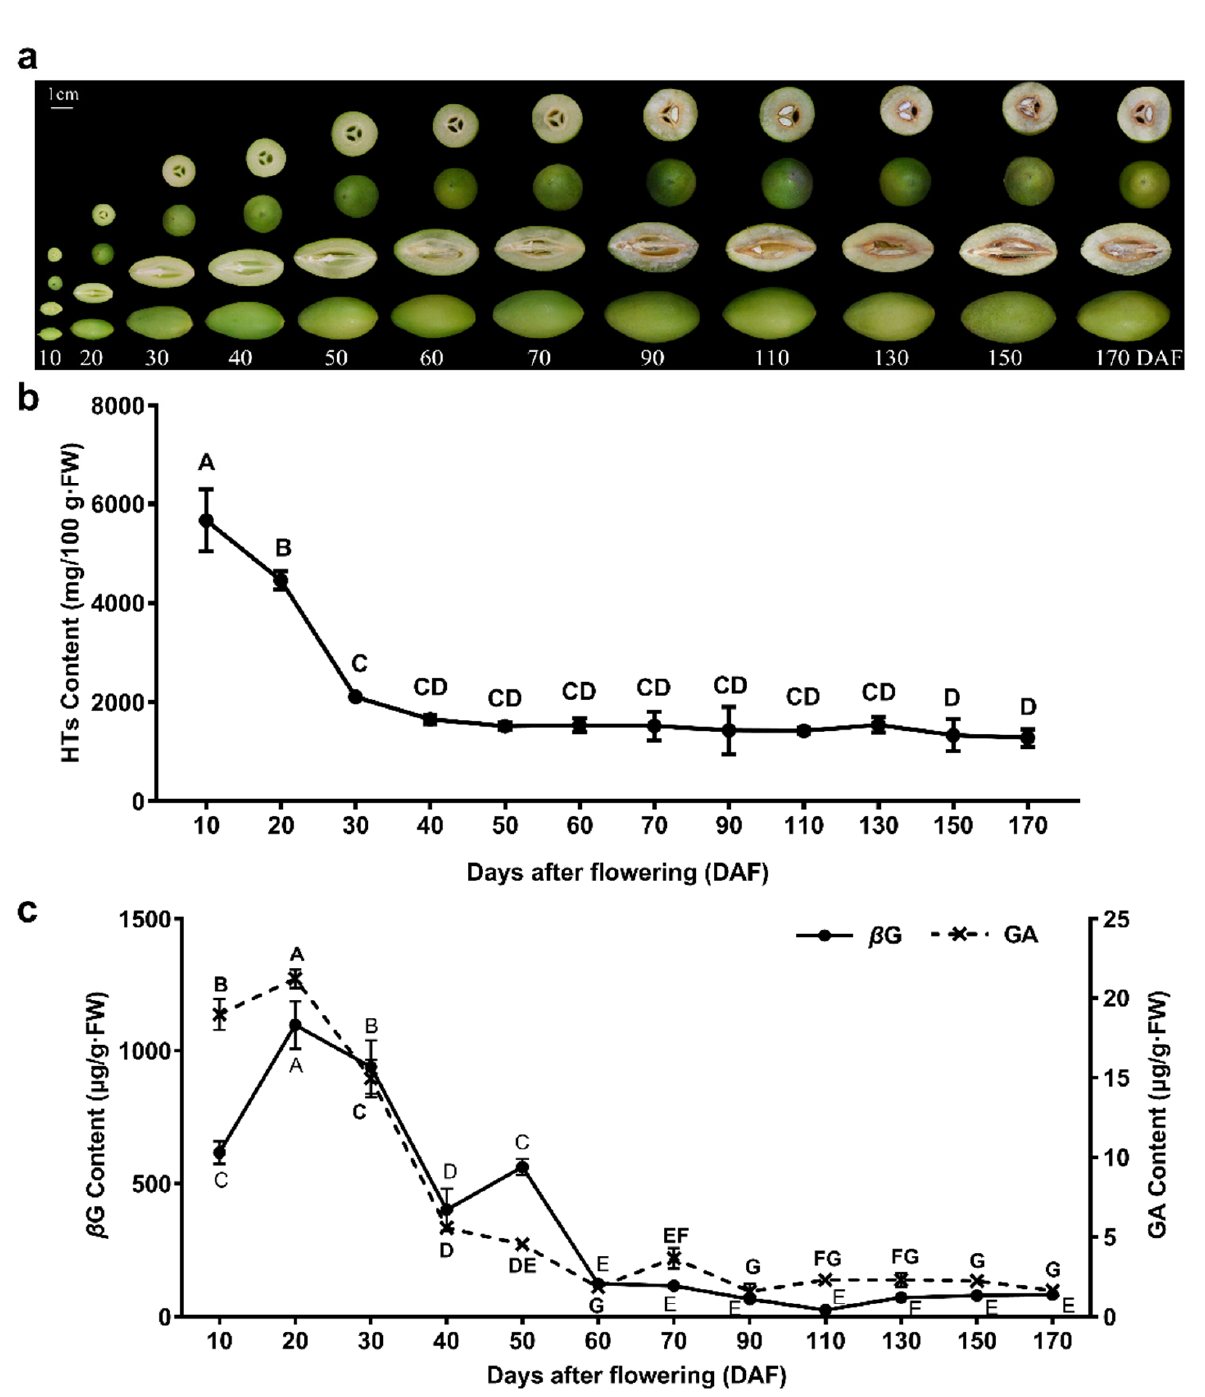
Figure 1. C. album fruit development and phenolic substance content. ( a ) The exterior and interior characteristics of C. album fruits in different development stages; ( b ) hydrolysable tannin (HT) content of C. album fruits in different development stages; ( c ) gallic acid (GA) and 1-Galloyl- β - D -glucose ( β G) contents of C. album fruits in different development stages. Each data point is the average mean of five reactions ± SD. Different uppercase letters indicate significant differences at p < 0.01 levels, based on the Tukey–Kramer test.